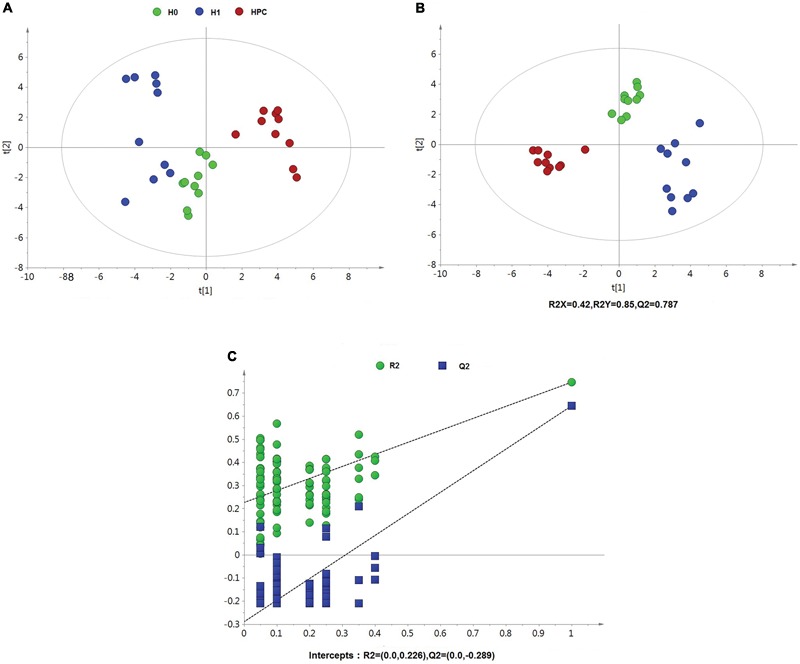
Multivariate data analysis based on hippocampus spectral data of UHPLC-QTOFMS negative ion mode. (A) PCA score map derived from UHPLC-QTOFMS spectra concerning H0, H1, and HPC groups. (B) PLS-DA score map derived from UHPLC-QTOFMS spectra concerning H0, H1, and HPC groups. (C) Validation plot obtained from 99 permutation tests.